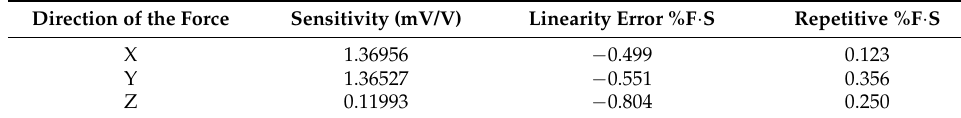
Table 1. Main performance parameters of sensor 1 (see Figure 8).